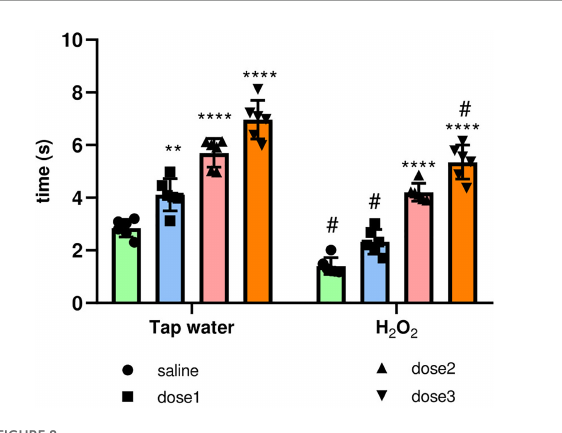
FIGURE8 Effect of the interaction between the extract treatment and the exposure to H 2 O 2 on hyperalgesia evaluated by the tail immersion test. The latency of the tail withdrawal reflex was measured. The results were presented as mean ± SD ( n = 6). Data were analyzed by Two-ways ANOVA followed by Bonferroni’s post-hoc test; ** p ≤ 0.01, **** p ≤ 0.0001 compared to saline group in the